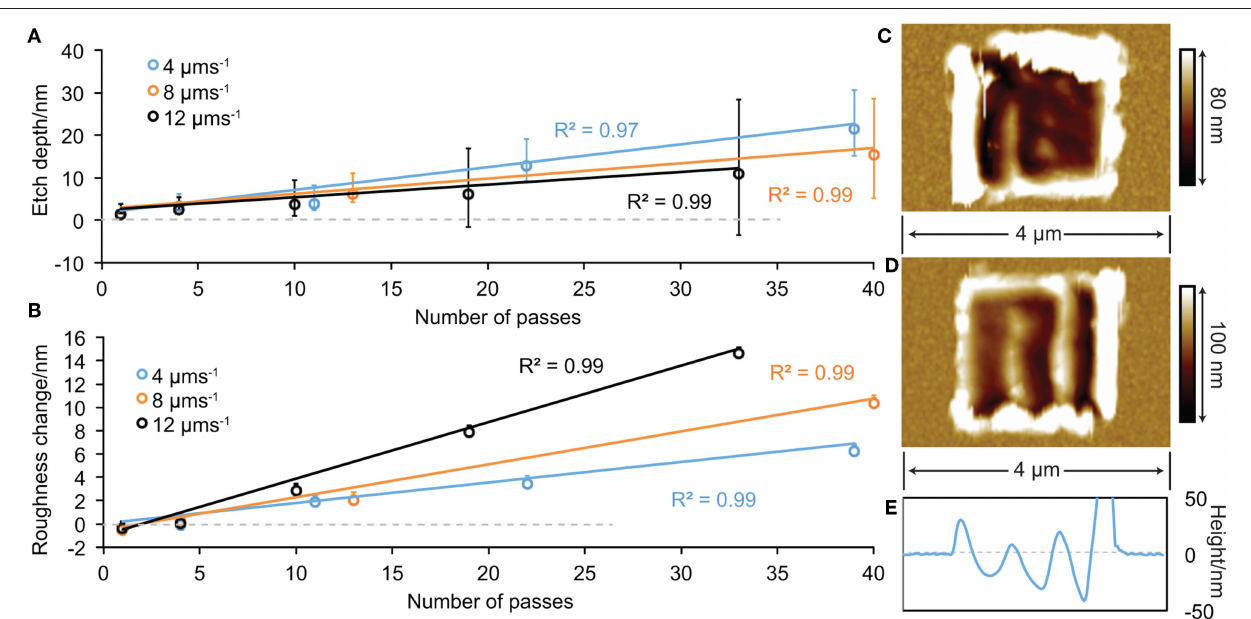
FIGURE 8 | The effect of tip speed and number of passes when etching gold at 1.4 µ N with a diamond-coated probe. (A,B) Etch depth and roughness change, respectively. The lowest speed produces the deepest and smoothest trench, though the roughness is always significant in comparison to the depth. (C) Topography of the trench produced for 39 passes at 4 µ ms − 1 . There is a distinct wave-like pattern perpendicular to the fast scan axis. (D,E) Topography and step profile, respectively, of the trench produced for 33 passes at 12 µ ms − 1 . This was the roughest trench and displays a severe wave-like pattern perpendicular to the fast scan axis.